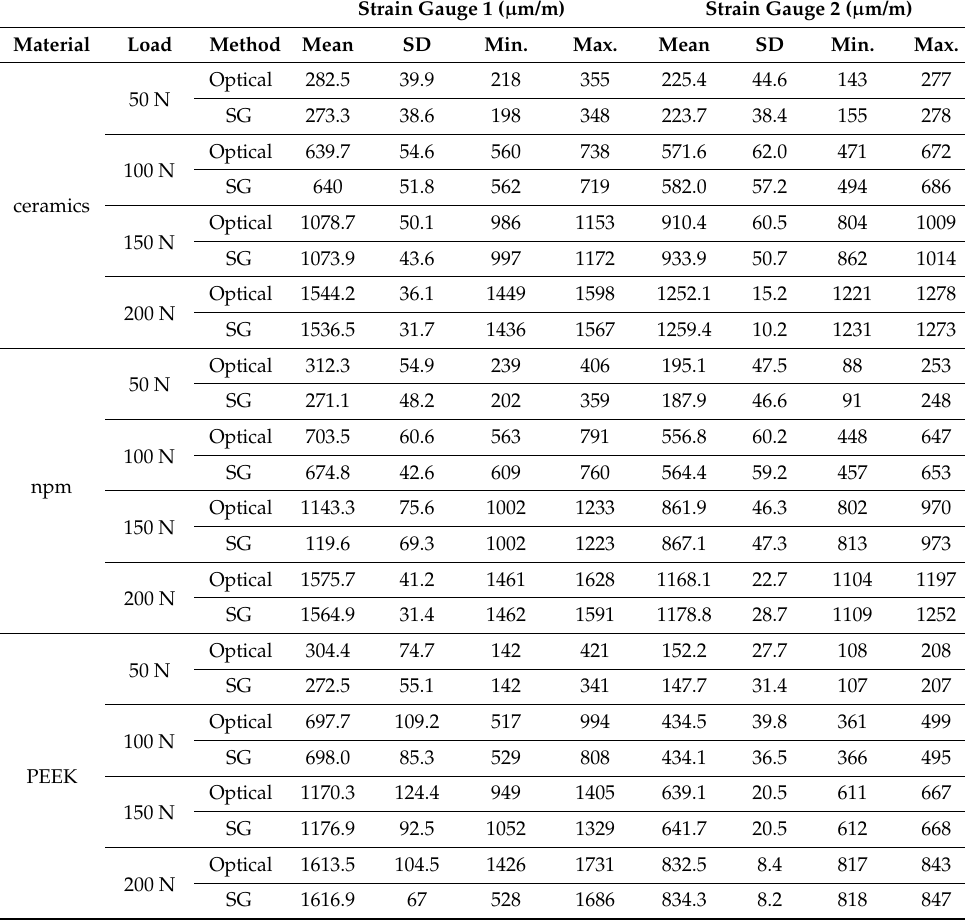
Table 1. Mean values, minima, maxima, and standard deviation (SD) of the individual series of measurements for the optical measuring method and strain gauges (SG) 1 and 2, for ceramic, non- precious metal (npm), and PEEK, respectively. All values are displayed in µ m/m.